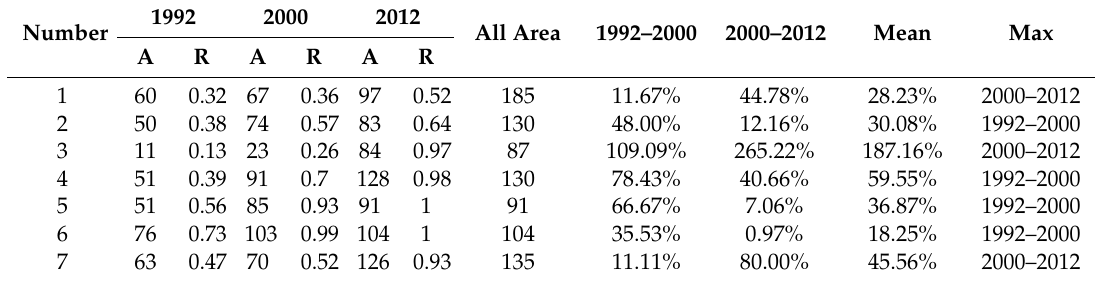
Table 6. Statistics of the built-up areas within the economic corridor for Wuhan.